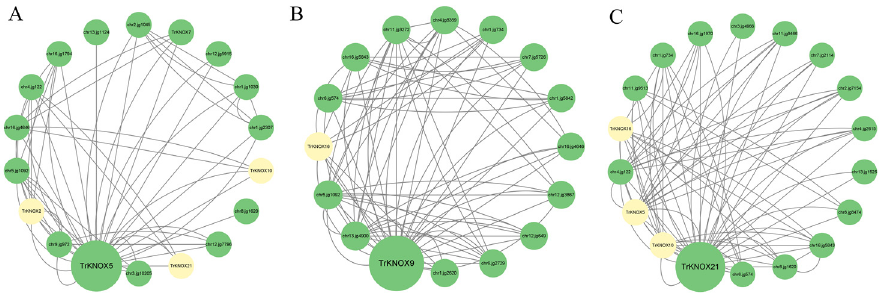
Figure 9. Interactions between three essential proteins ( A . TrKNOX5, B . TrKNOX9, and C . TrKNOX21) regulate leaf development and other proteins in T. repens . Nodes represent protein, and yellow indicates other TrKNOX protein family members; green represents other proteins.